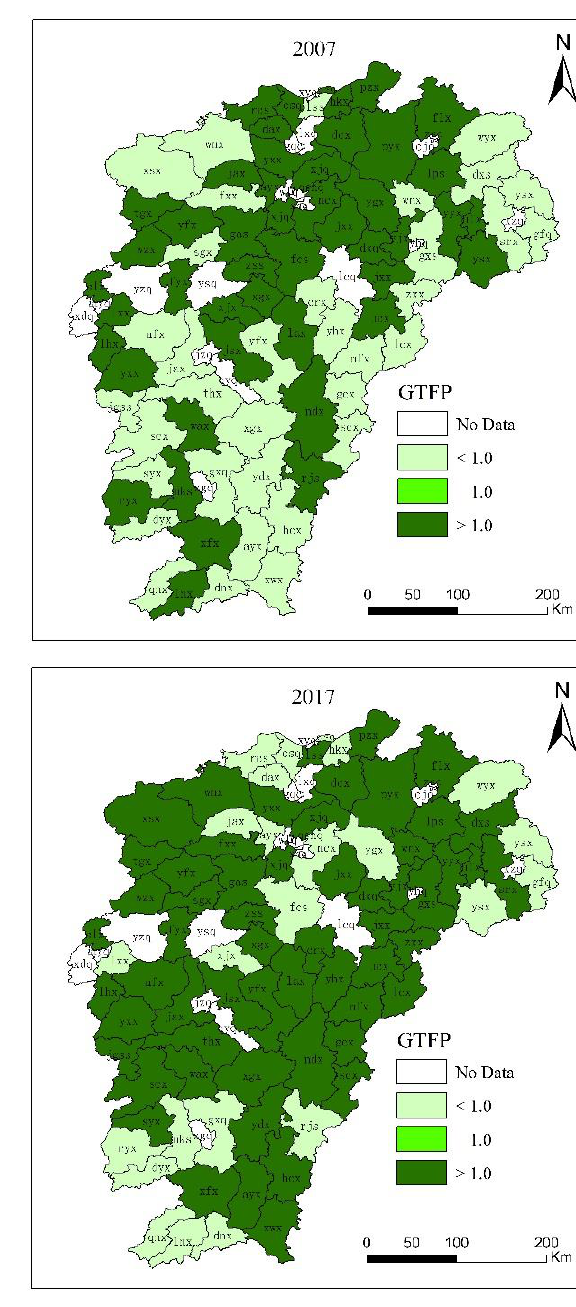
Figure 2. Spatial pattern evolution of GTFP of grain in Poyang Lake Basin from 2001 to 2017.